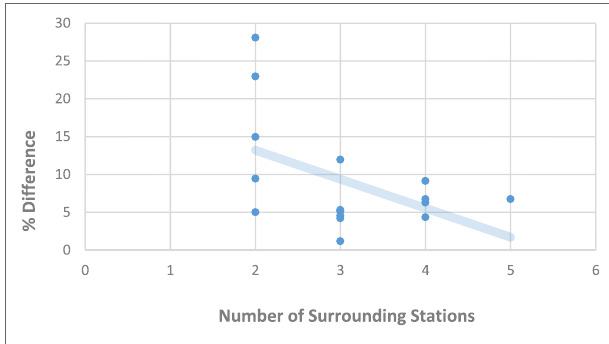
FigUre 1 | Percent difference versus number of surrounding stations.